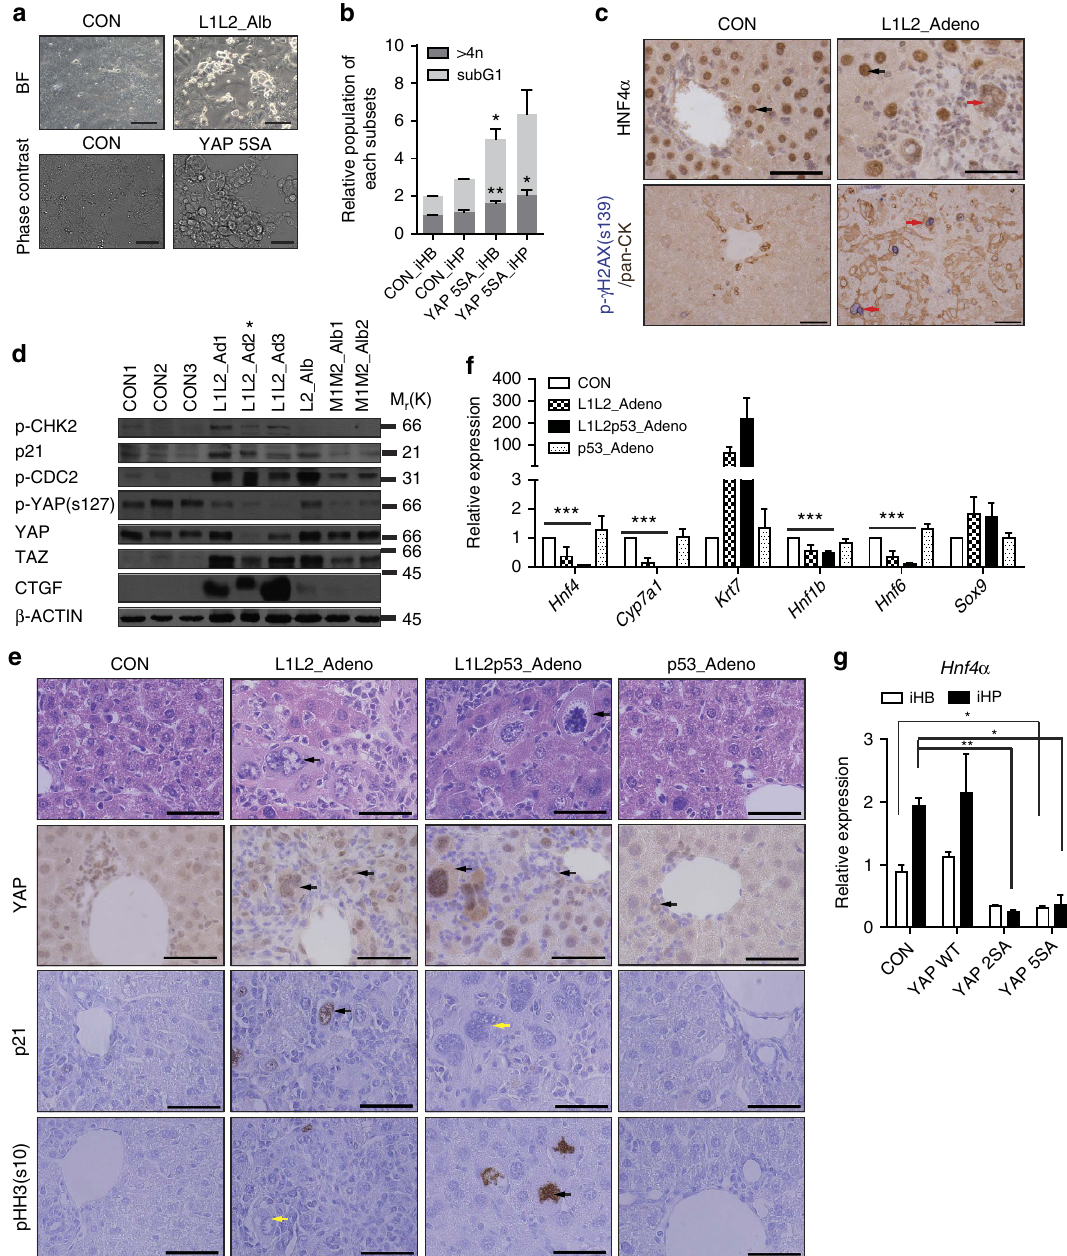
Figure 6 | Hyper-activation of YAP induced oncogenic stress-induced senescence or apoptosis, which does not affect hepatocyte differentiation. ( a ) Representative bright-field (upper) and phase contrast (lower) images of in vitro differentiated hepatocytes from control cells, L1L2_Alb hepatoblasts (upper, scale bars, 50 m m) and YAP 5SA over-expressing hepatoblasts (lower, scale bars, 100 m m). ( b ) fluorescence-activated cell sorting (FACS) analysis of in vitro cultured hepatoblasts and hepatocytes. n ¼ 3. ( c ) Representative immunohistochemical results obtained with anti-HNF4 a (upper) and anti- phospho- g H2ax (S139) (lower) in control and L1L2_Adeno livers. Black arrows indicate normal hepatocytes; red arrows in ( c ) up indicate LCCs of hepatocytes and red arrows in ( c ) bottom indicate positive signal to p- g H2AX. Scale bars, 50 m m. ( d ) Western blot analysis of liver extracts from control and Lats1 (cid:2) / (cid:2) ; Lats2 fl/fl mice injected with adeno-Cre (L1L2_Ad; lanes 1–6), Lats2 fl/fl ; Alb-Cre (L2_Alb; lane 7, HCC) and Mst1 fl/fl ;Mst2 (cid:2) / (cid:2) ;Alb-Cre (Mst1/ 2_Alb; lanes 8 and 9, HCC). Asterisk indicates the lysate from livers with highly expanded fibrocytes. ( e ) Representative images of haematoxylin and eosin (H&E) staining and immunohistochemistry with antibodies against YAP, p21 and pHH3 (S10) in control, L1L2_Adeno, L1L2_p53_Adeno and p53_Adeno livers. In the H&E staining images, black arrows indicate LCCs of hepatocytes. In the immunohistochemical staining images, black arrows indicate positive signal to indicated antibodies and yellow arrows indicate a lack of staining. Scale bars, 50 m m. ( f ) Relative mRNA expression of hepatic and BEC markers in livers from mice of the indicated genotypes. ( g ) Relative Hnf4 a mRNA expression levels of control, YAP WT, -2SA and -5SA over-expressing iHPs. The data are presented as means ± s.e.m.; n ¼ 3, * P o 0.05, ** P o 0.01 and *** P o 0.005 (Student’s t